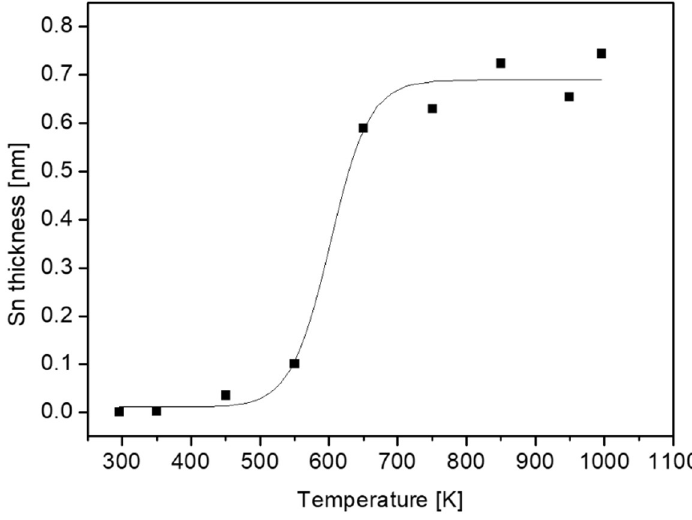
Figure 5. Sn layer thickness at the surface of the ZrNiSn alloy as a function of annealing temperature.